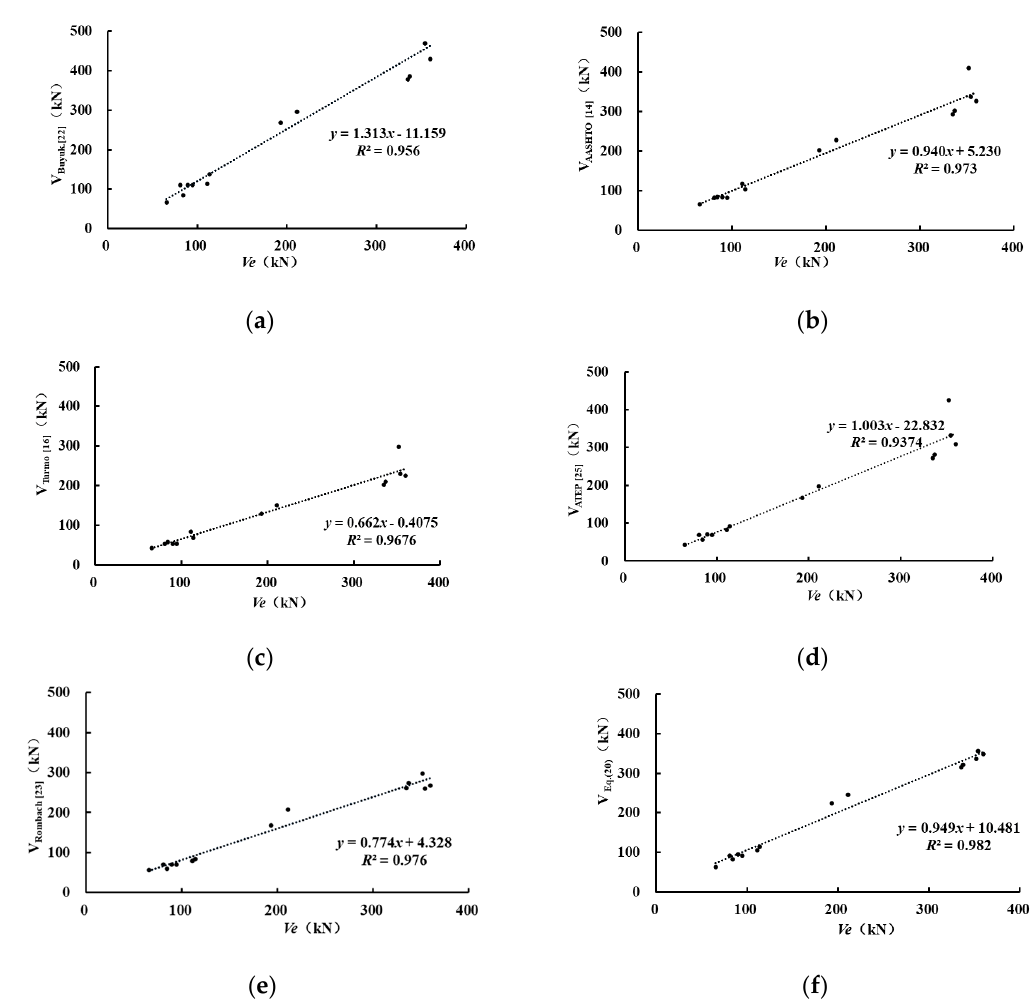
Figure 18. Relation between the experimental and predicted joint shear strength of different formulas.